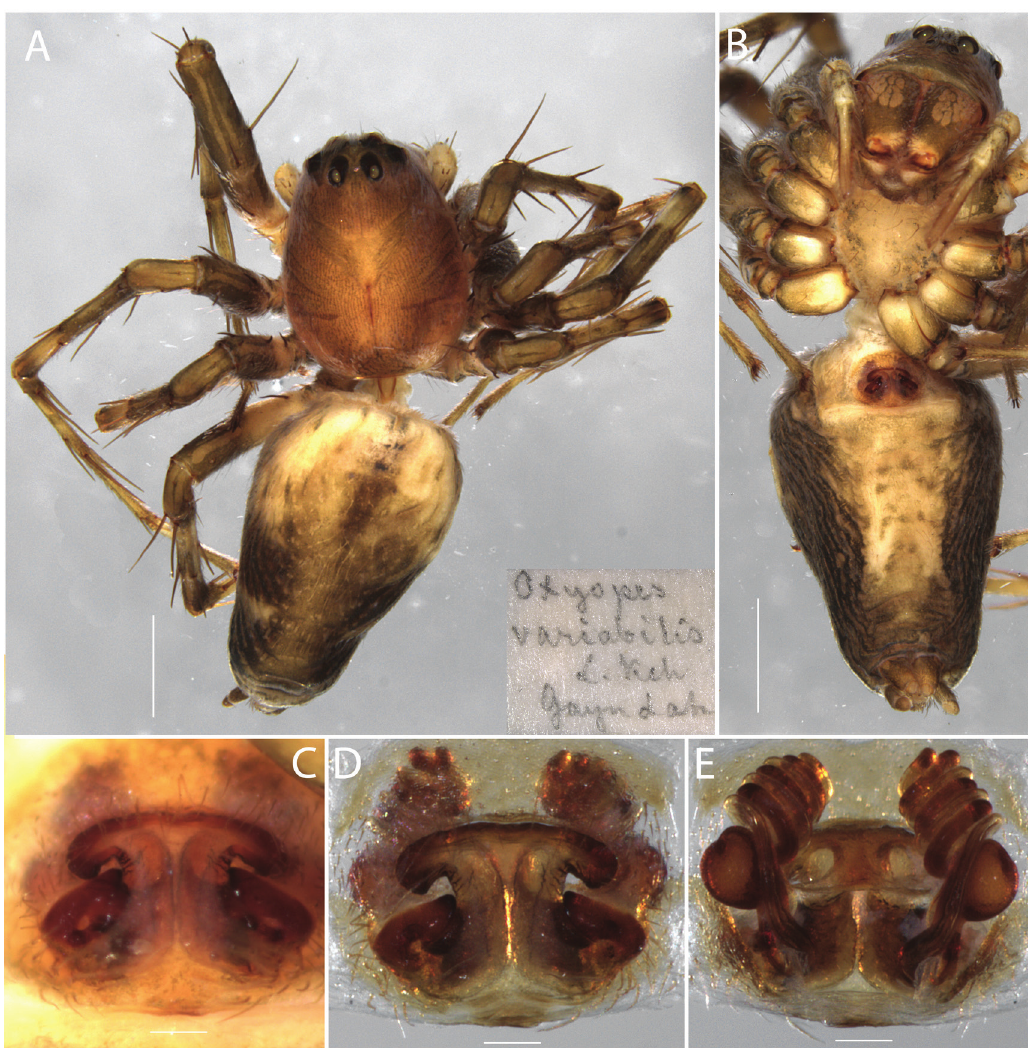
Figure 18. Oxyopes variabilis L. Koch, 1878, female lectotype (ZMH- A0000021): A , habitus, dorsal view; B , habitus, ventral view; C , epigyne, ventral view; D, epigyne, ventral view, cleared; E , epigyne, dorsal view, cleared. Scale bars: habitus 1.0 mm, epigyne 0.1